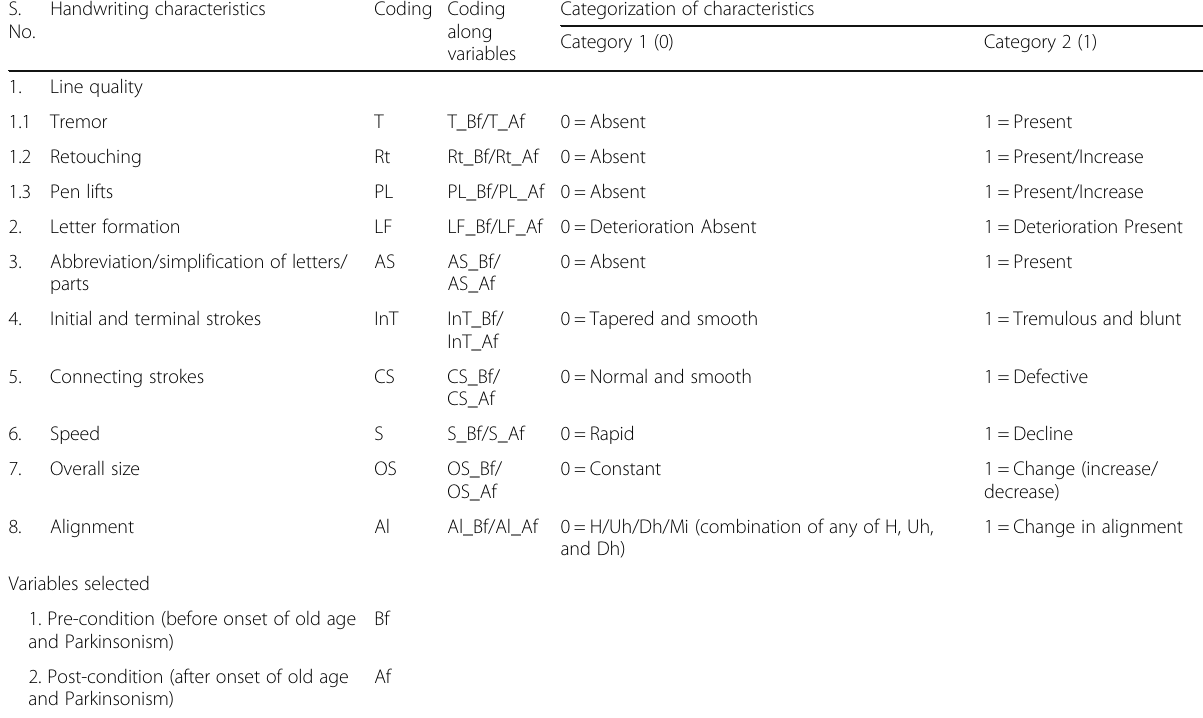
Table 2 Coding and categorization of handwriting characteristics along variables observed during